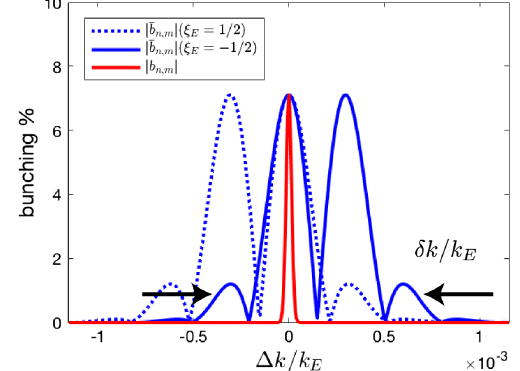
FIG. 7. Harmonic bunching spectrum envelopes (blue) of EEHG, and bunching harmonic spike (red), for a E ¼ 100 with A ¼ 3 , n ¼ − 1 . The excitation bandwidth δ k=k 1 ; 2 of the envelope, which shifts position depending on the sign of optimal ξ E